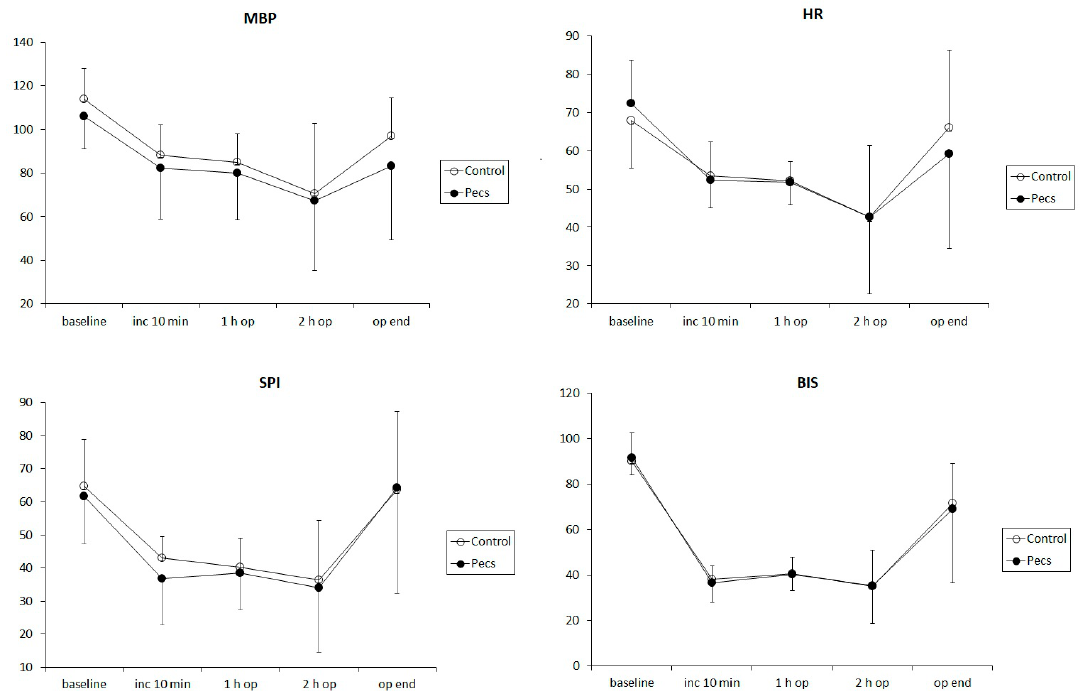
Figure 2. Intraoperative changes in the mean blood pressure (MBP, left upper), heart rate (HR, right upper), surgical pleth index (SPI, left lower) and bispectral index (BIS, right lower). Error bars mean standard deviations of each value. Data were measured at 5 time points: at baseline, 10 min (inc 10 min), 1 h (1 h op), and 2 h (2 h op) after the surgical incision, and at the end of surgery (op end), respectively. There were no intergroup differences in the changes in MBP, HR, SPI, and BIS during the surgery. The patients either received a pectoral nerve block type II (Pecs group, filled circle) or not (control group, unfilled circle).